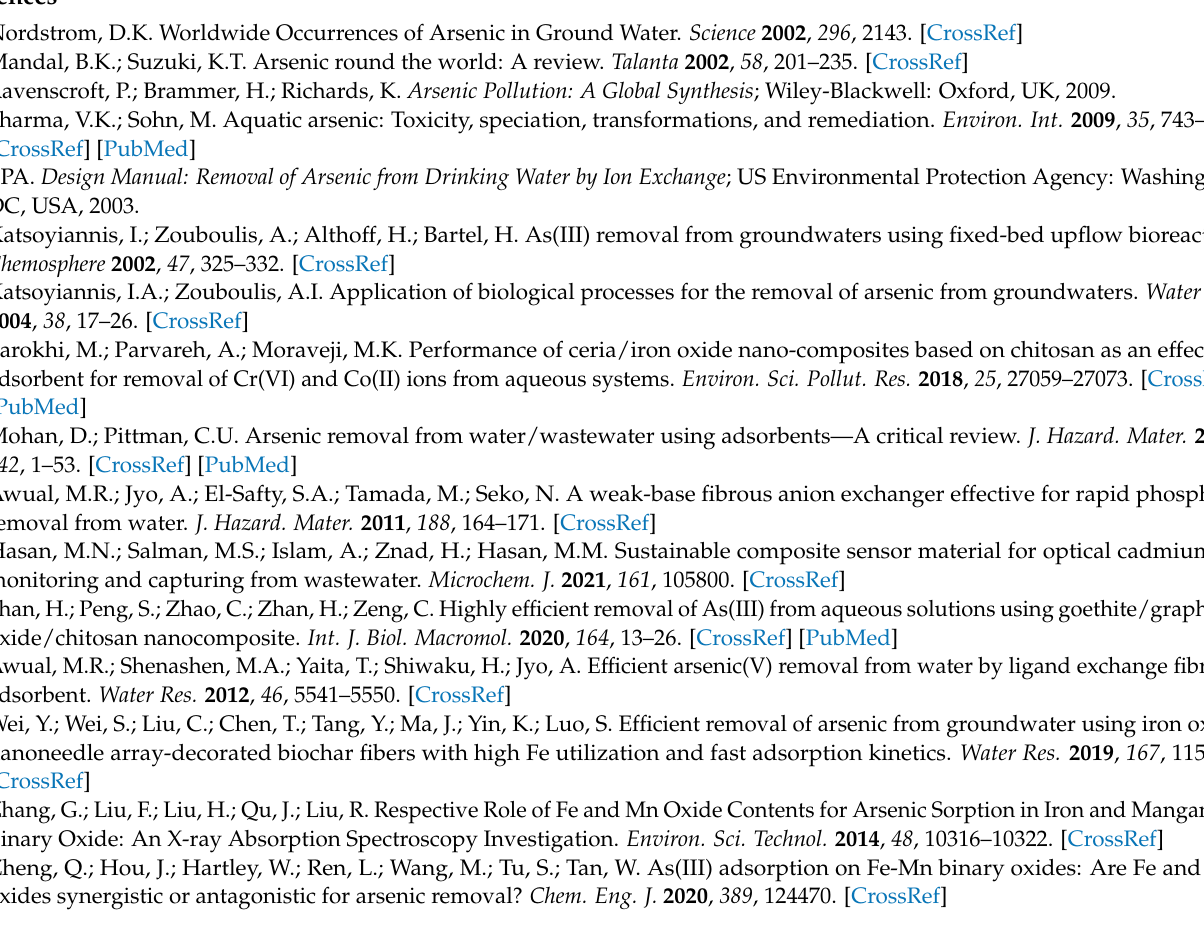
Figure S2: BET analysis of the GOCS: (a) adsorption/desorption isotherm plots, (b) bar graphs of the BET and BJH surface areas, and (c) BJH plots of the pore size distribution; Figure S3: SEM images and EDS results of GOCS composite microsphere. Figure S4: The changes in the ζ potential of adsorbent with the pH values; Figure S5: Variations of pH values after As(III) adsorption; Figure S6: Removal efficiency (Re) of MGOCS for different heavy